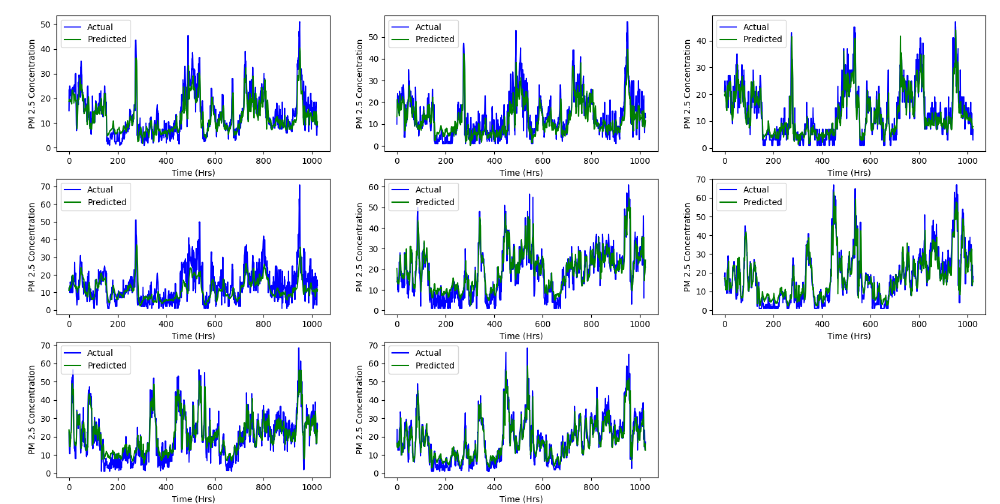
Figure 8. The predicted results of CNNLSTM.